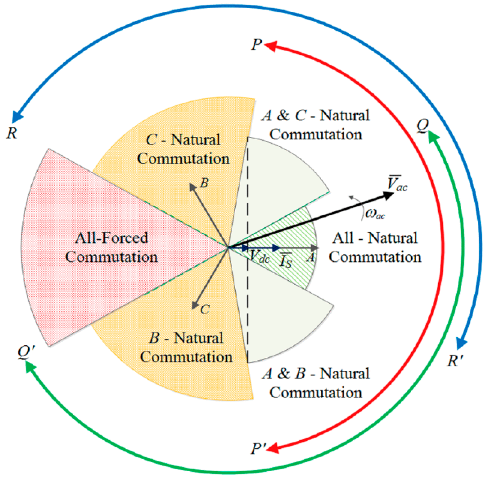
Figure 18. Commutation diagram during dc-to-ac source transition [10].